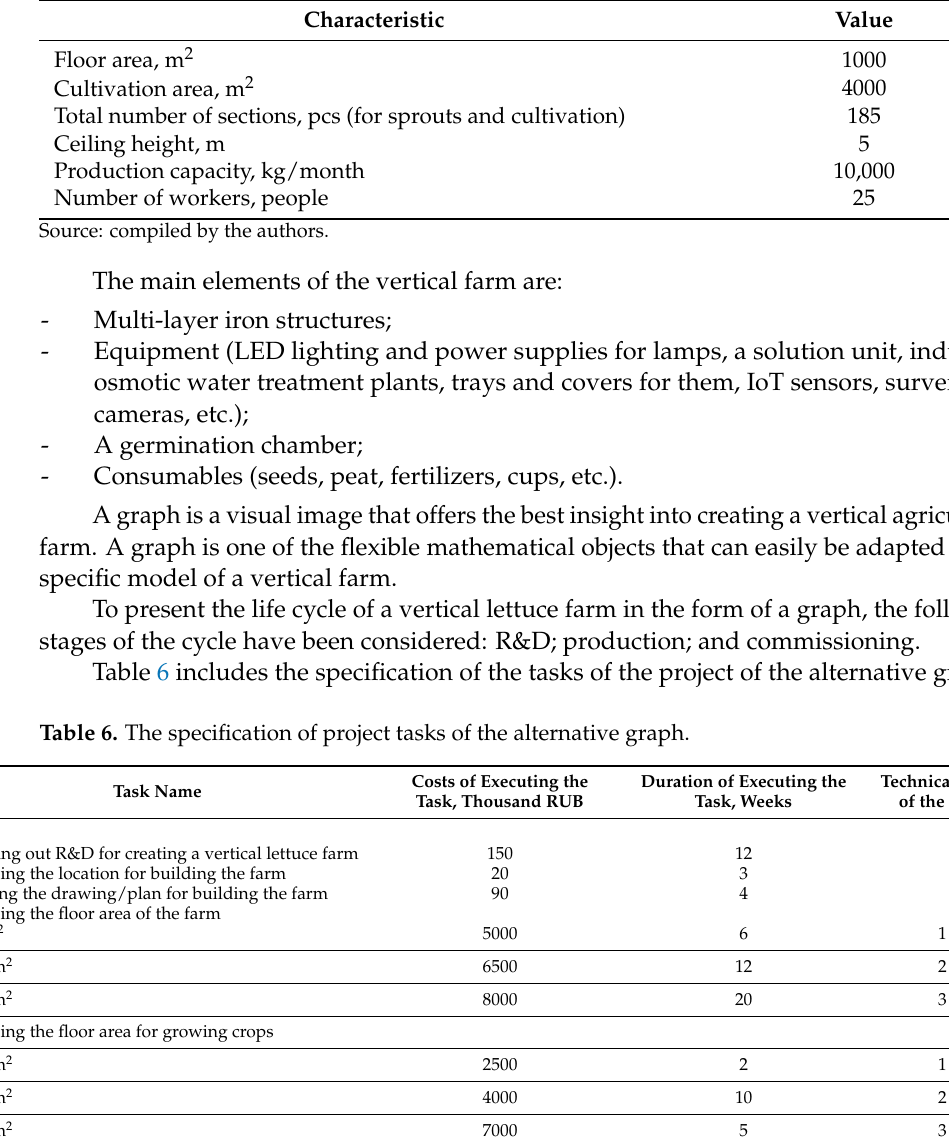
Table 5. Technical characteristics of the vertical agricultural farm.